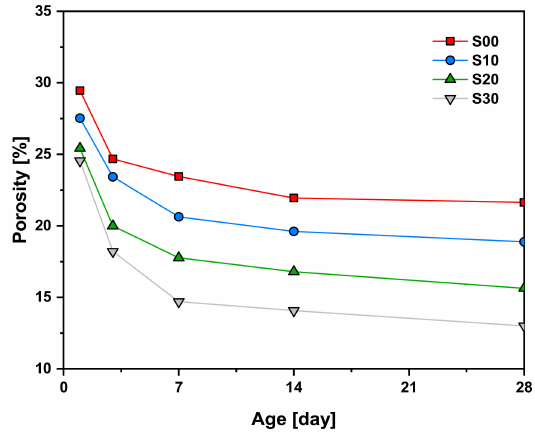
Figure 5. Total porosities of cement mortars blended with